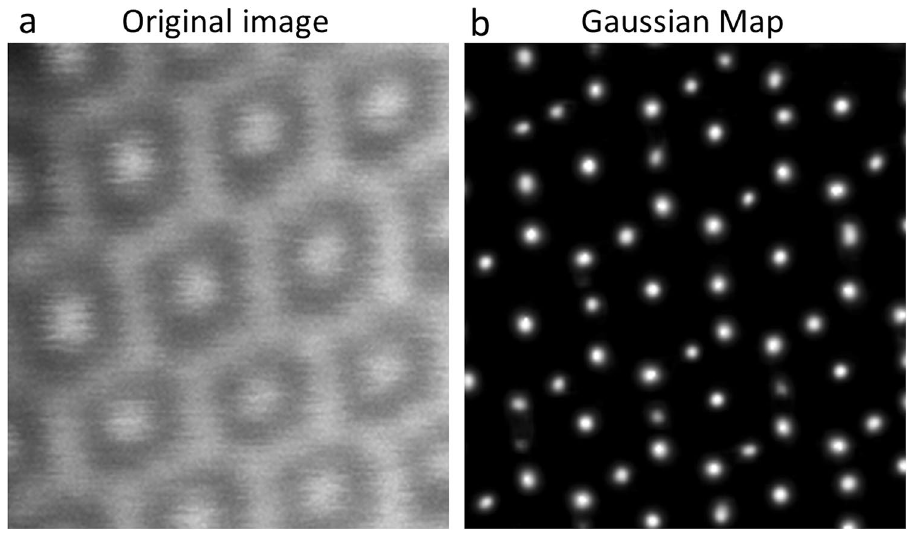
Figure 10. The ‘unknown known’ test on a spinel structured Co 3 O 4 material. ( a ) The ADF-STEM image of Co 3 O 4 . ( b ) The atomic-column Gaussian